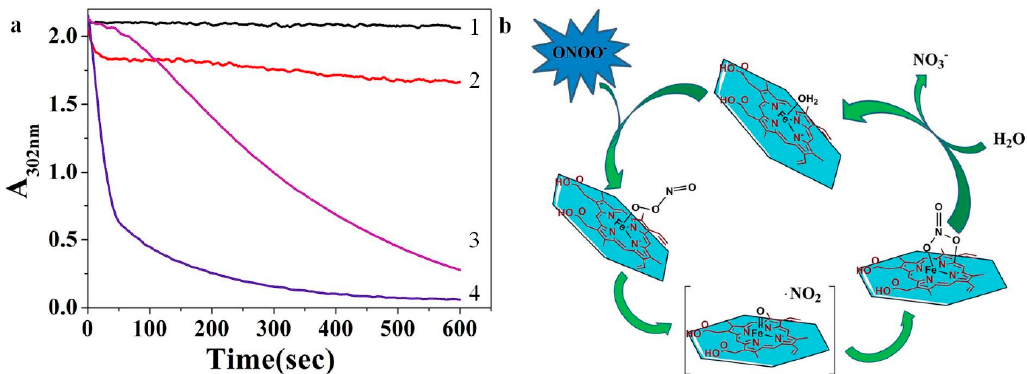
Figure 11. Peroxynitrite decomposition without (1) and with equivalent weight of LDHs (2), hemin (3) and hemin-LDHs (4). Peroxynitrite was mixed with scavengers at 25 ◦ C and the reaction was followed at 302 nm ( a ). Proposed mechanism for the isomerization and reduction of ONOO − and scavenging of NO 2 ∙ by hemin-LDH hybrid nanosheets ( b ). Reproduced from Reference [171] with permission from the Royal Society of Chemistry.